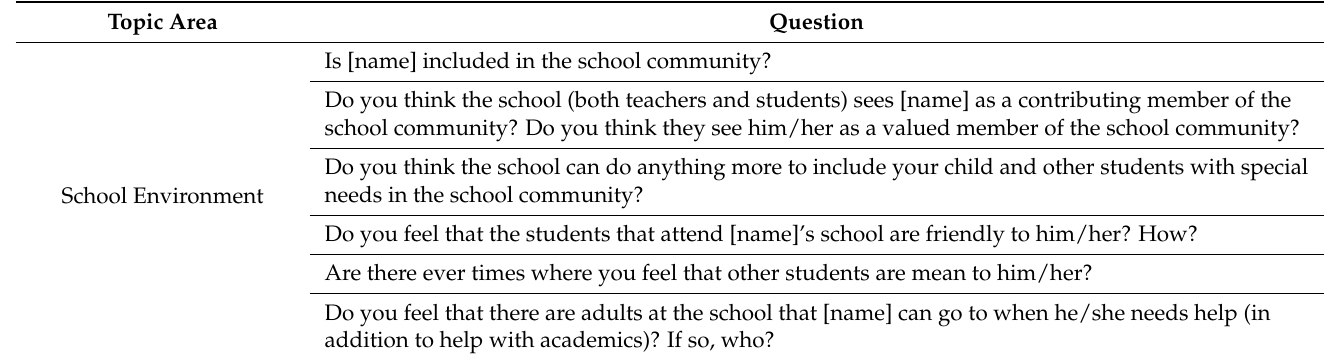
Table 2. Family Member Interview